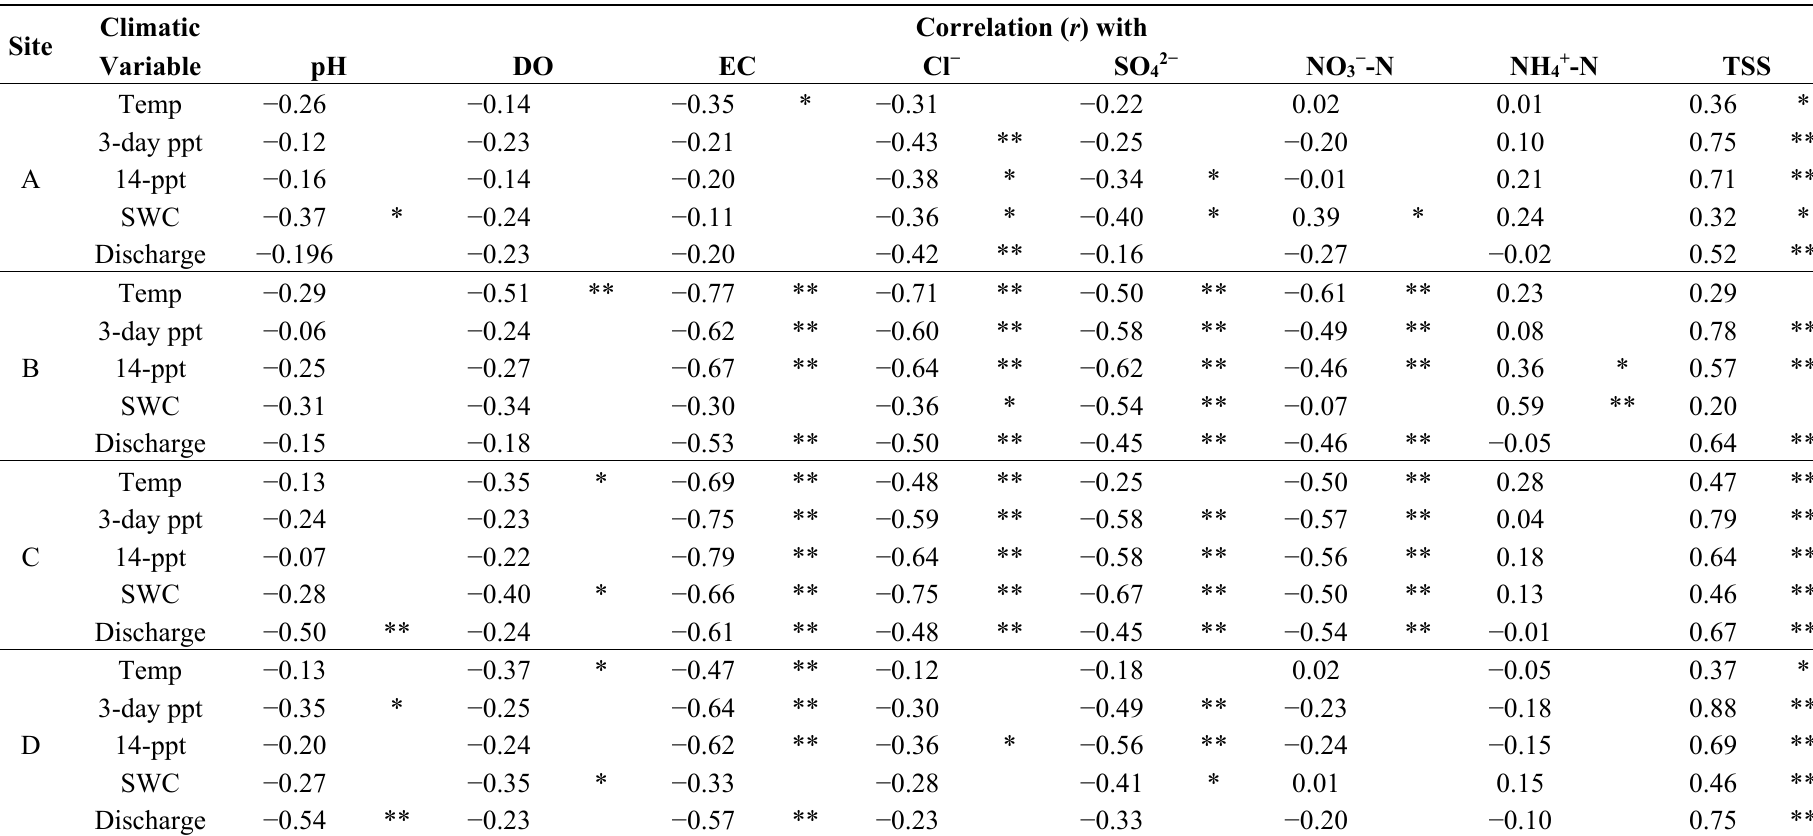
Table 2. Correlations between bi-weekly water chemistry data (pH, DO, EC, and concentrations of Cl − , SO 4 2 − , NO 3 − –N, NH 4 + –N, and TSS) in four streams and climatic variables including air temperature (Temp), 3-day antecedent precipitation (3-day ppt), and 14-day antecedent precipitation (14-ppt), soil water content (SWC) at 30 cm, and discharge. Asterisks indicate statistical